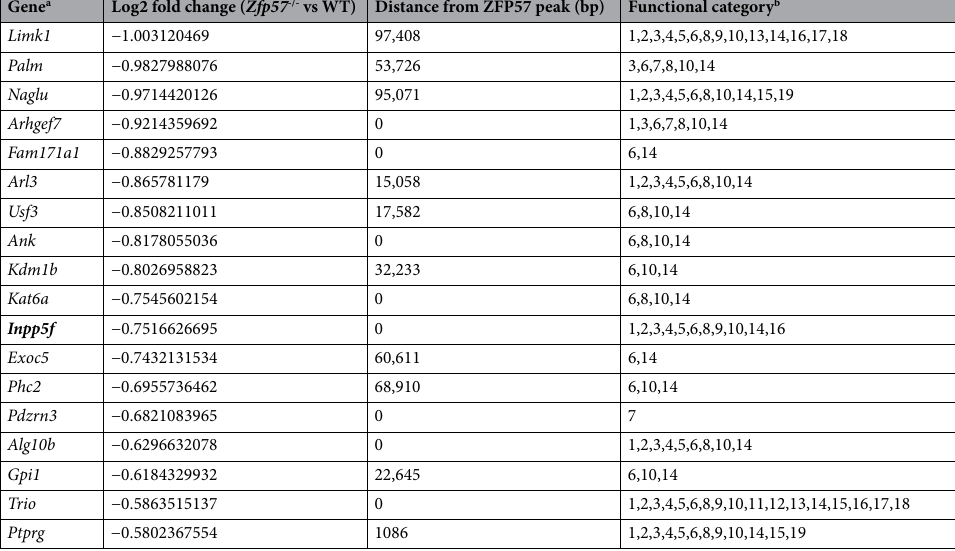
Table 1. Zfp57 -/- day 12-JB1 cells down-regulated genes located < 100 kb from ZFP57/KAP1 binding sites and involved in neuronal and developmental functions. a Imprinted genes are in bold. 2 GO Category are as follows: 1. GO:0022008(neurogenesis), 2. GO:0048666(neuron development), 3. GO:0007399(nervous system development), 4. GO:0048699(generation of neurons), 5. GO:0030182(neuron differentiation), 6. GO:0048856(anatomical structure development), 7. GO:0050808(synapse organization), 8. GO:0048731(system development), 9. GO:0031175(neuron projection development), 10. GO:0007275(multicellular organism development), 11. GO:0007411(axon guidance), 12. GO:0097485(neuron projection guidance), 13. GO:0048667(cell morphogenesis involved in